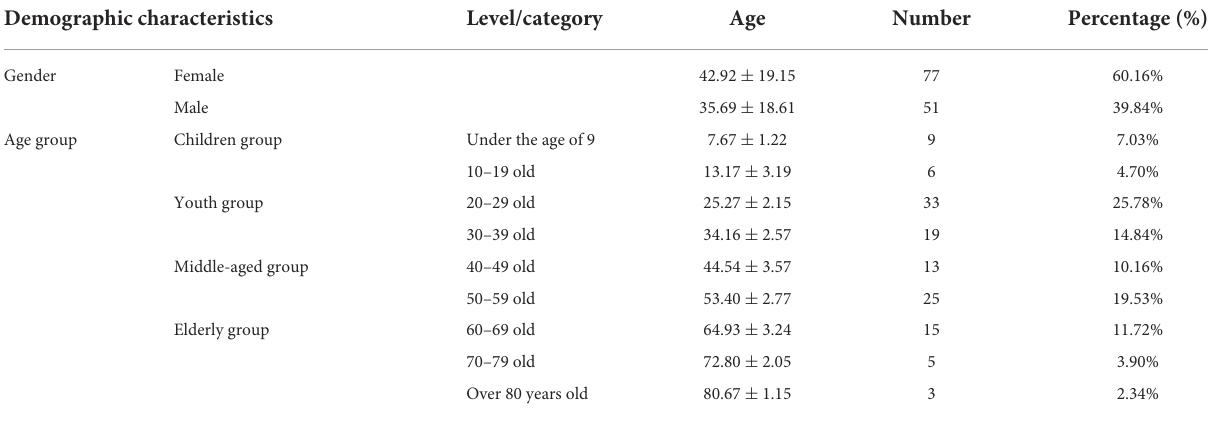
TABLE 1 Statistical table of demographic characteristics of the